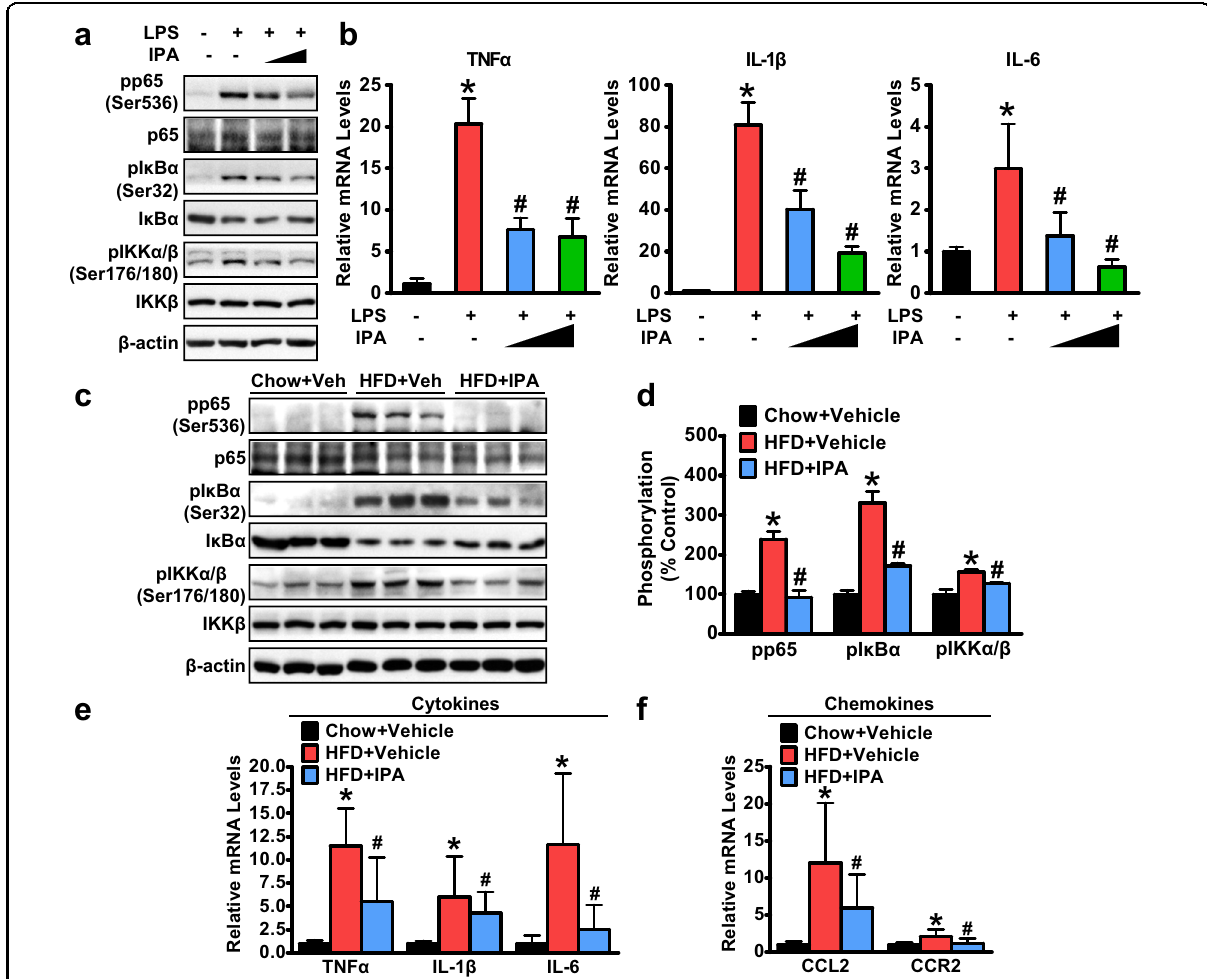
Fig. 5 IPA inhibits the activation of NF- κ B signaling and the production of proin fl ammatory cytokines in macrophages in response to endotoxin. a , b IPA inhibits NF-kB signaling in murine J774A.1 macrophages. Cells were pretreated with IPA (250 μ M and 500 μ M) for 1 h, followed by 500 ng/mL LPS treatment for an additional 30 min. a Representative immunoblots are shown. b Expression levels of proin fl ammatory cytokines were determined by real-time PCR. Relative expression levels were normalized to those of GAPDH. The data are presented as the mean ± SEM ( n = 4). * P < 0.05 vs. vehicle; # P < 0.05 vs. LPS treatment. c – f IPA inhibits NF- κ B signaling in the livers of HFD-fed rats. Representative immunoblots ( c ) and densitometric quanti fi cation ( d ) from three rats in each group are shown. Relative phosphorylation levels were normalized to those of endogenous proteins except for phosphorylated I κ B α , which was normalized to β -actin. The expression levels of cytokine genes (TNF α , IL-1 β , and IL-6) ( e ) and chemokine genes (CCL2 and CCR2) ( f ) were determined by real-time PCR. Relative expression levels were normalized to those of GAPDH. The data are presented as the mean ± SEM. n = 7 – 10, * P < 0.05, vs. rats fed a chow diet; # P < 0.05, vs. rats fed a high-fat